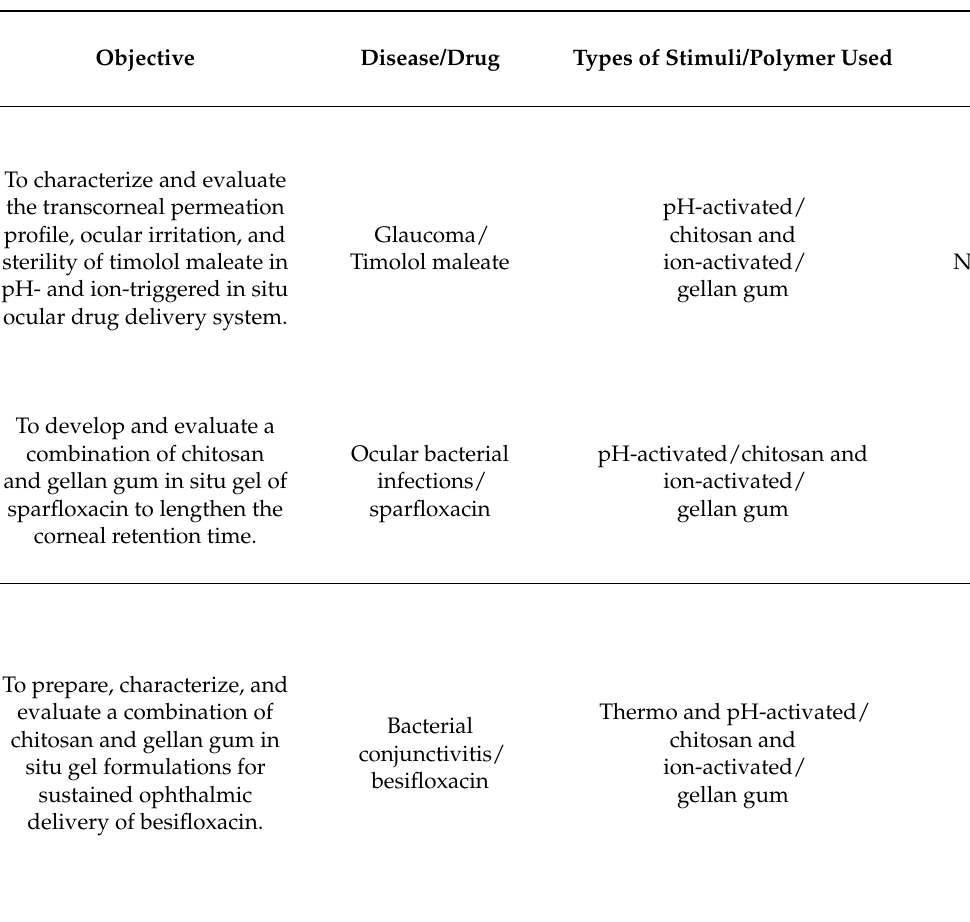
Table 4. Smart ocular delivery using multi-stimuli-responsive in situ gel approach against ocular